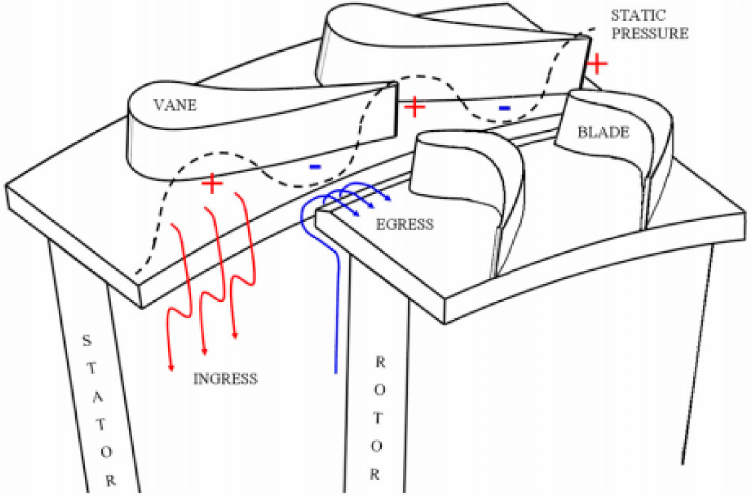
Figure 5. Rotor-stator disk cavity [5]. Reprint with permission from ASME (order number